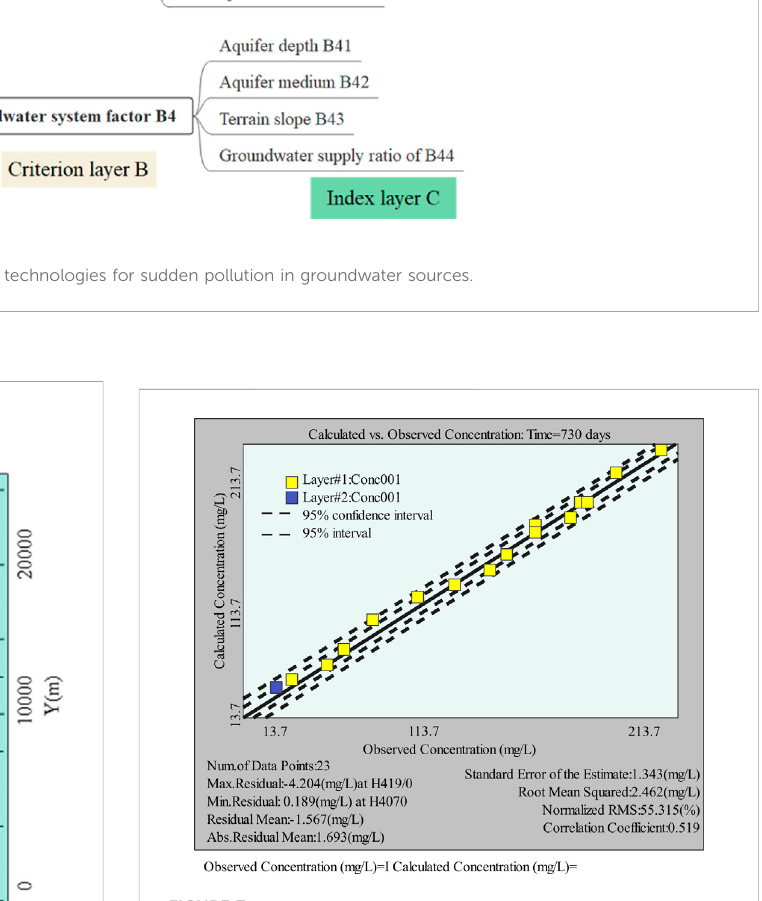
FIGURE 7 Concentration fi tting diagram in the validation